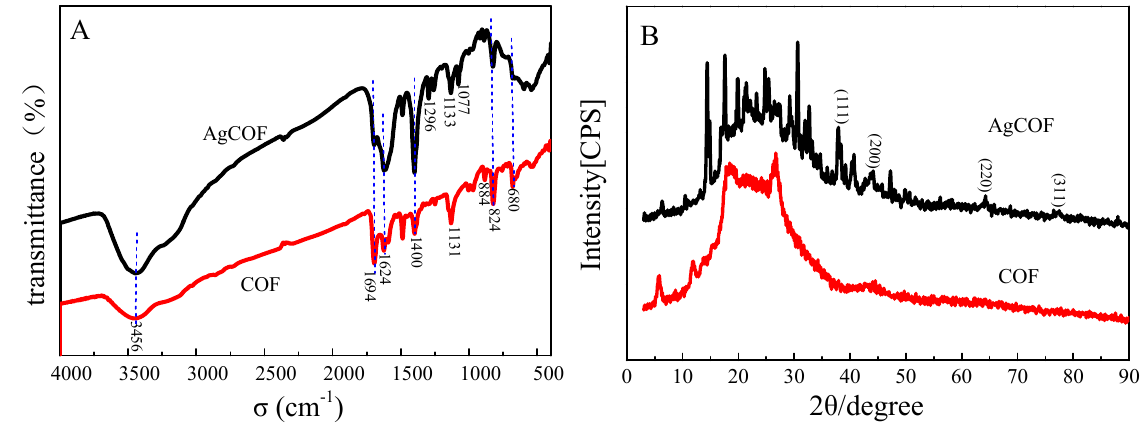
Figure 4. ( A ) FTIR spectra of COF and AgCOF; ( B ) XRD of COF and AgCOF.